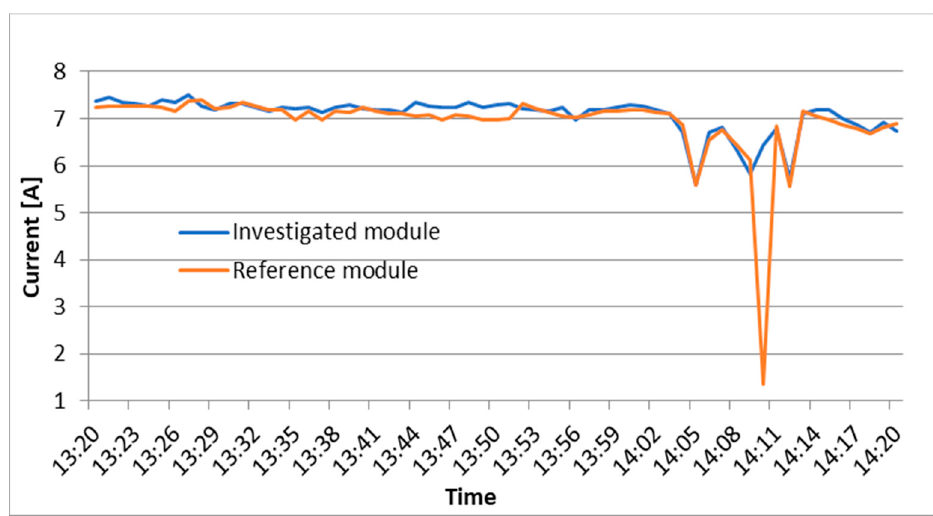
Figure 14. Current of investigated and reference modules during the maximal power test.